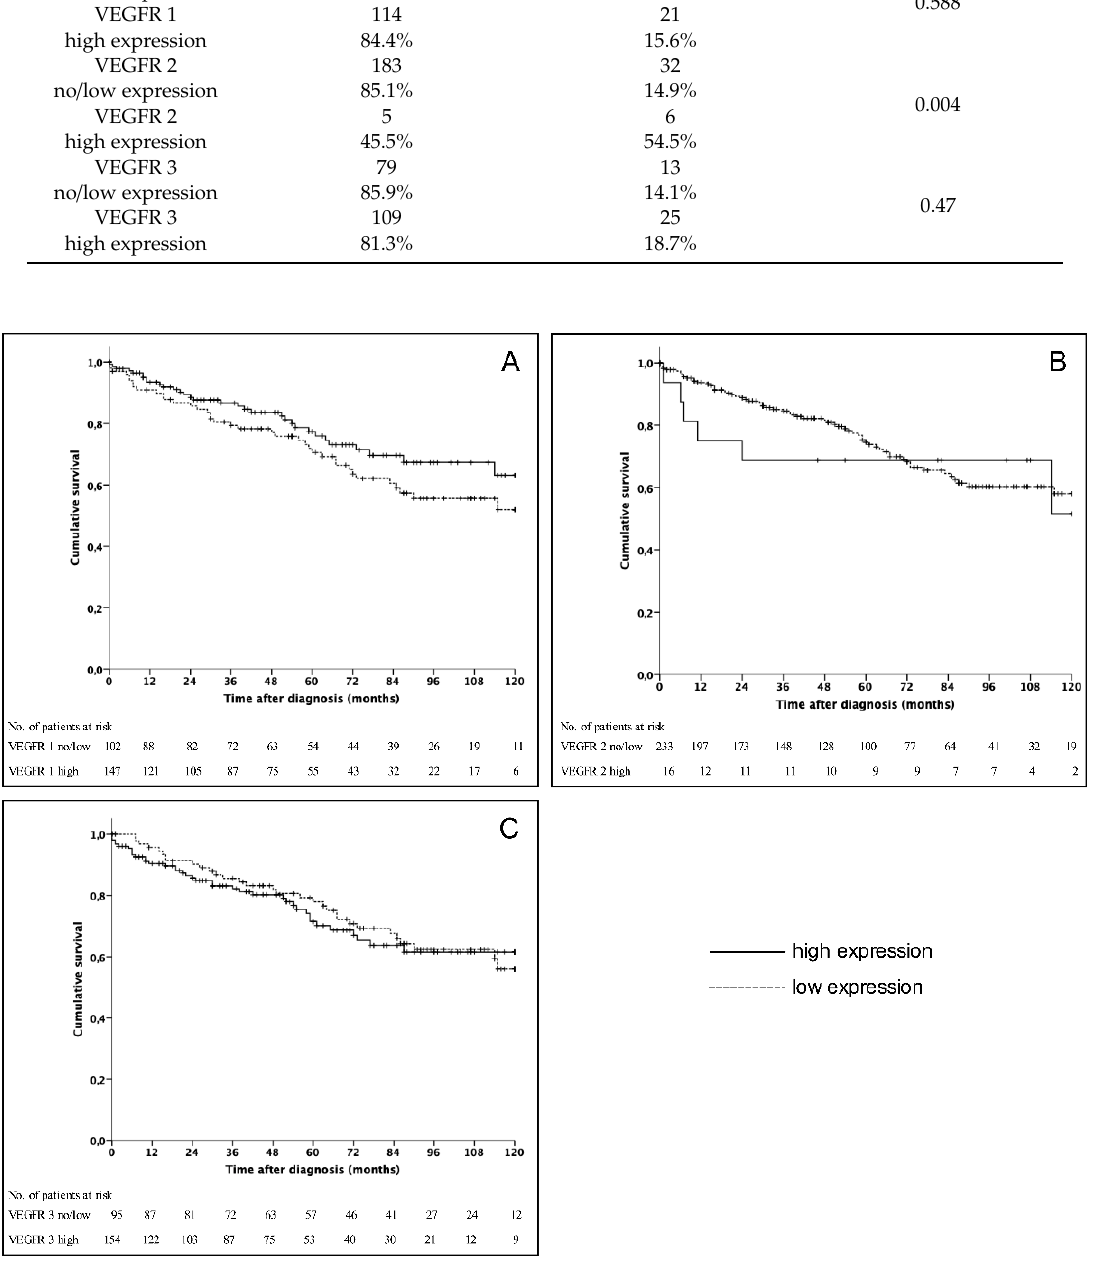
Figure 2. Kaplan–Meier survival curves for patients divided into VEGFR 1 ( A ) ( p = 0.15), VEGFR 2 ( B ) ( p = 0.723), and VEGFR 3 ( C ) ( p = 0.708).